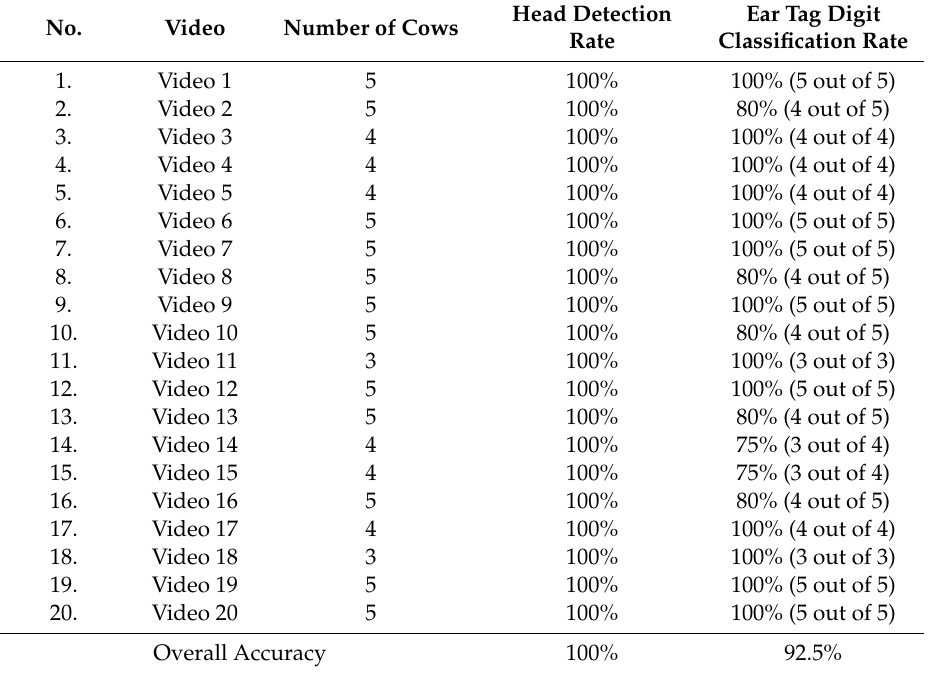
Table 4. Experimental results for head detection and ear tag digit